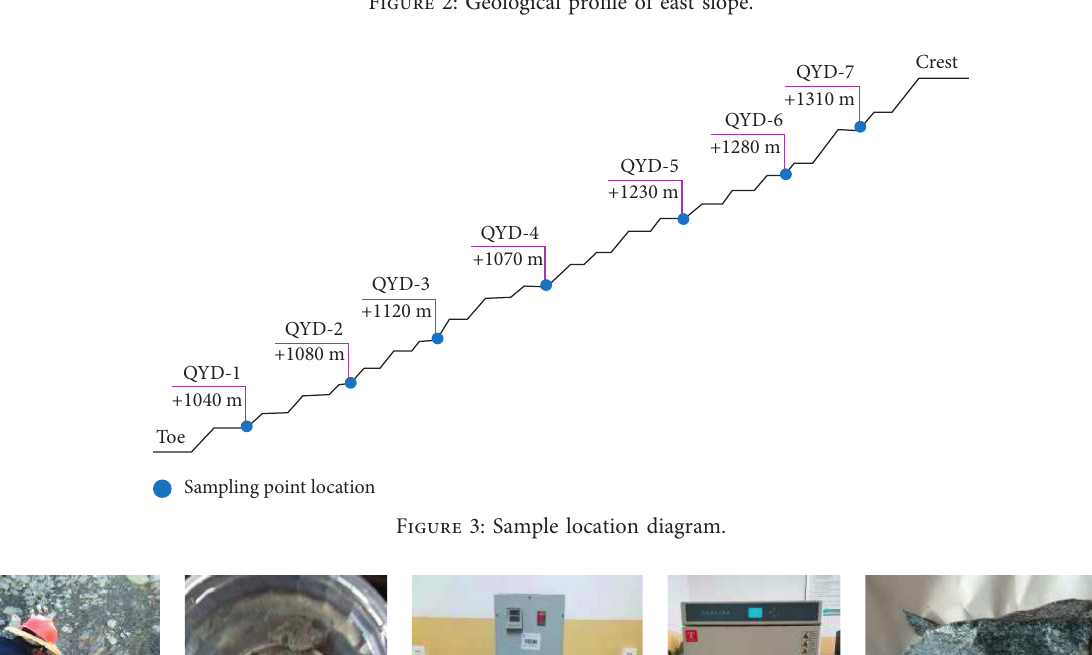
Figure 2: Geological profile of east slope.